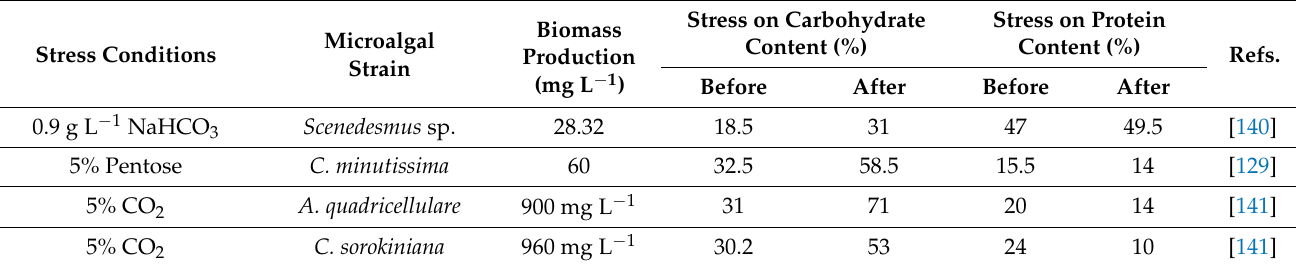
Table 5. Effect of different carbon sources on the biomass production and metabolite content of